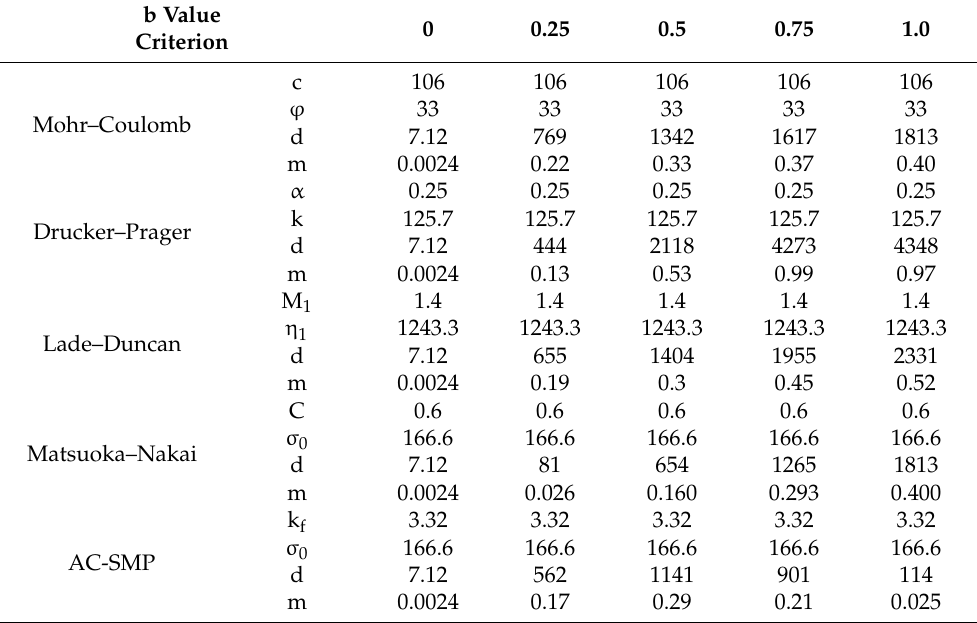
Table 2. Fitting parameters and evaluation indexes of each strength criterion.